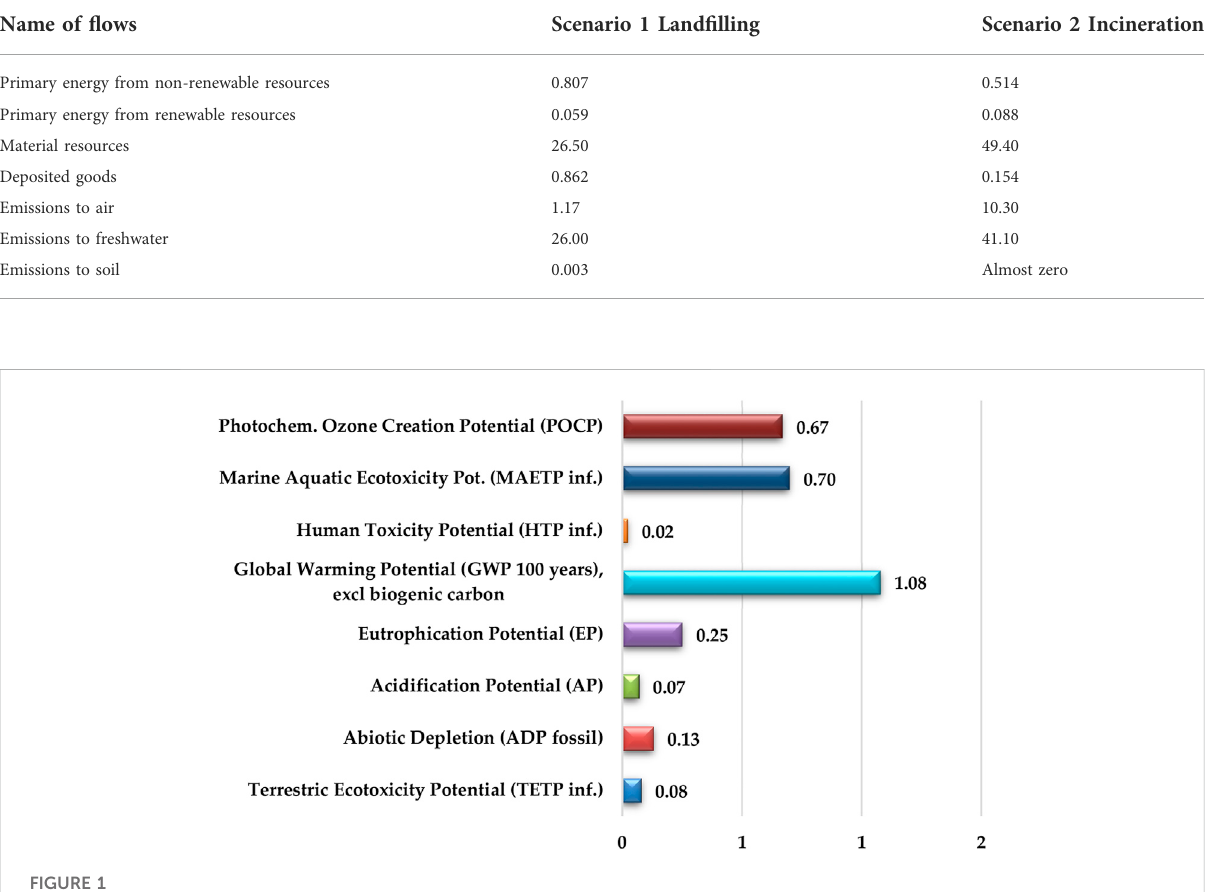
TABLE 1 Resources and emissions for treatment scenarios in kilograms (FU: 1 kg of MSW).